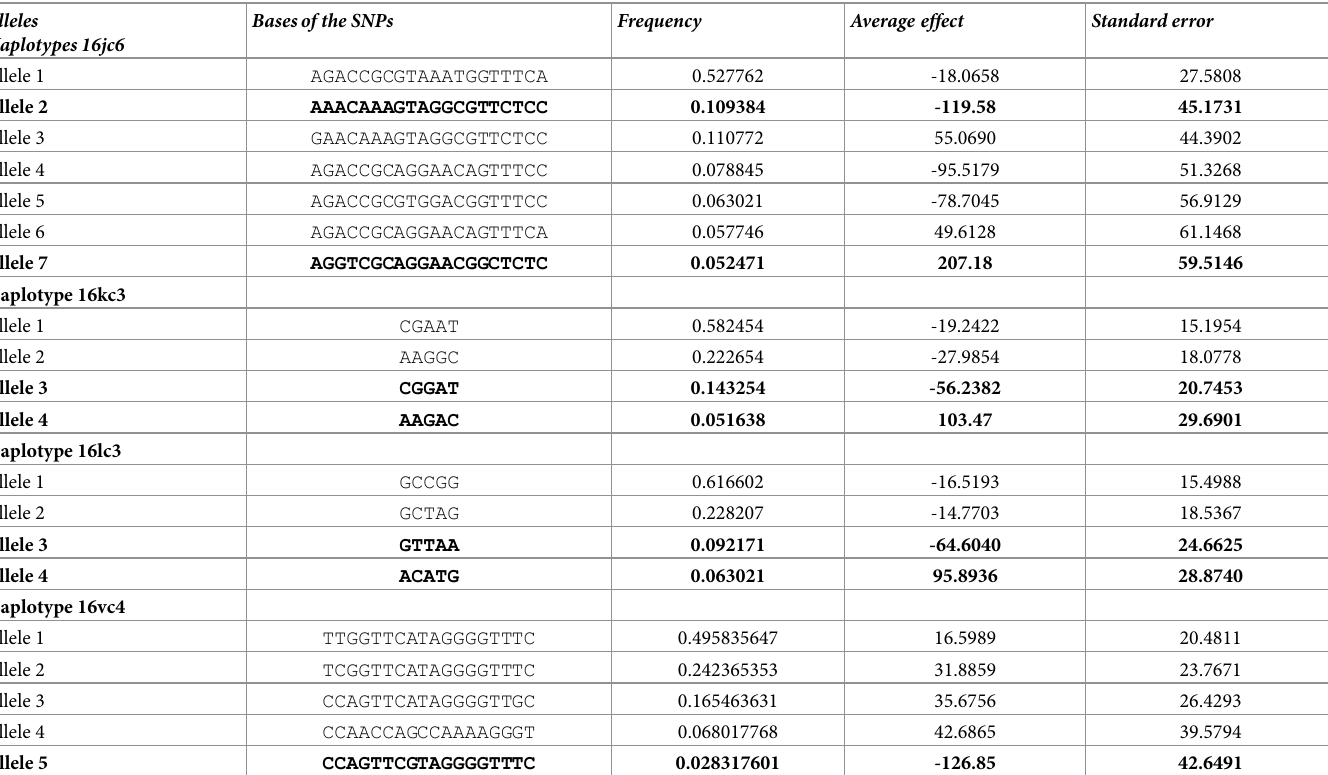
Table 1. Frequency, average effect, and respective standard error of haplotypes alleles located in the PAPP-A2 gene. Alleles Haplotypes 16jc6